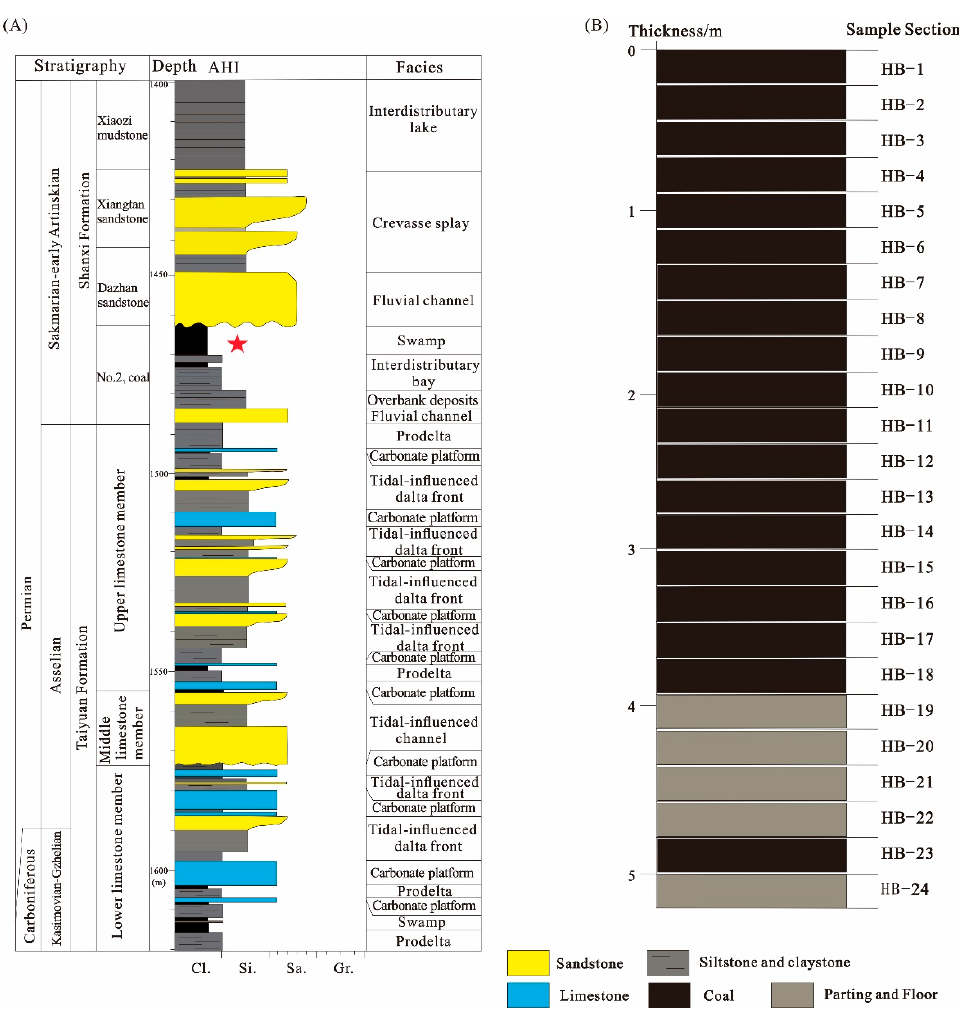
Figure 1. Location of the Hebi No. 6 mine of the Anhe Coalfield, North China.